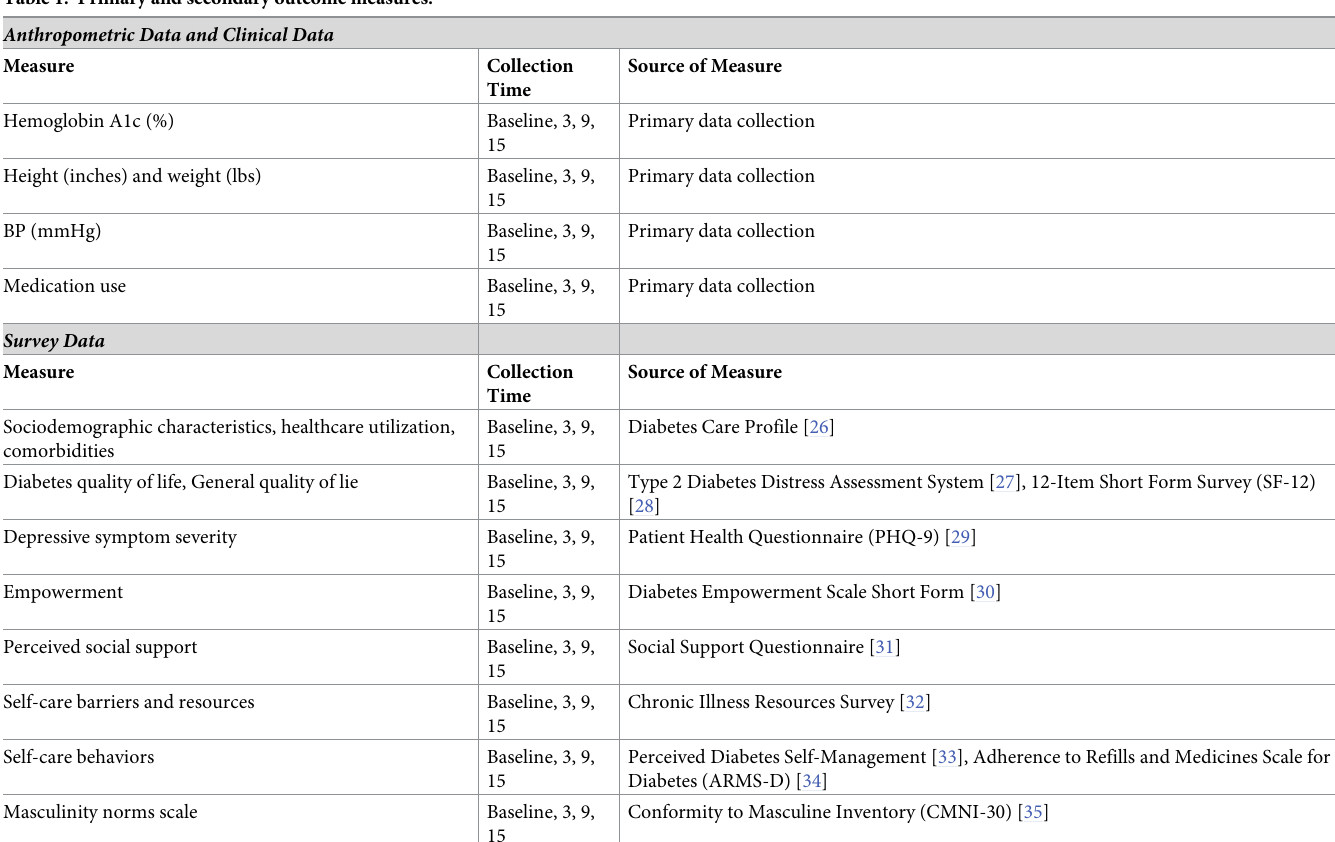
Table 1. Primary and secondary outcome